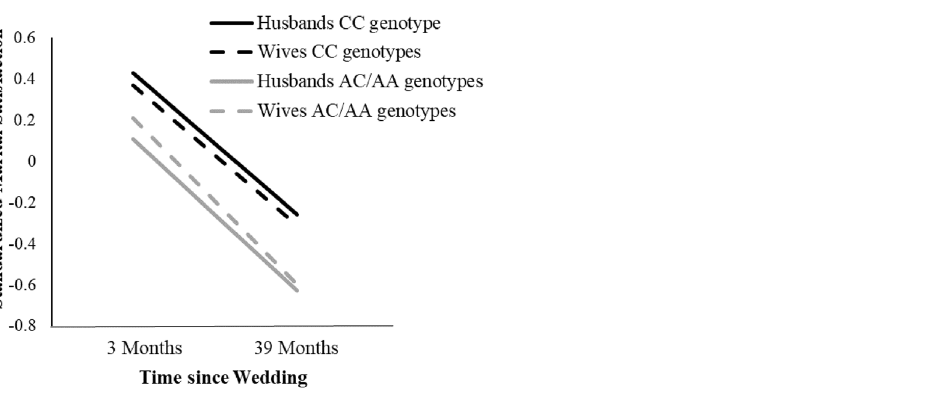
Figure 2. Associations between CD38 rs3796863 and marital satisfaction over the first 3 years of